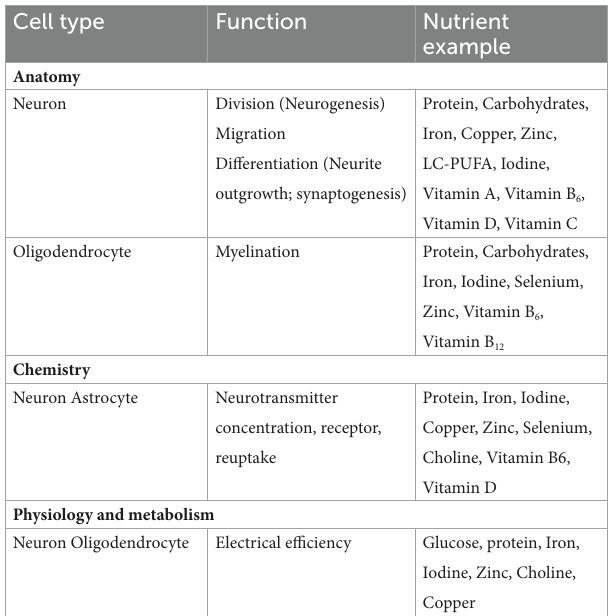
TABLE 1 Critical processes during neurodevelopment affected by specific